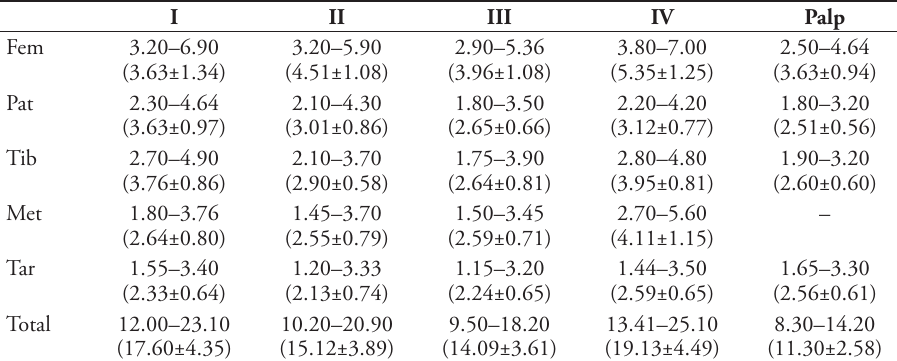
Table 4. Legs and palp measurements [range (mean ± standard deviation)] of ♀ Phlogiellus longipalpus sp. n.